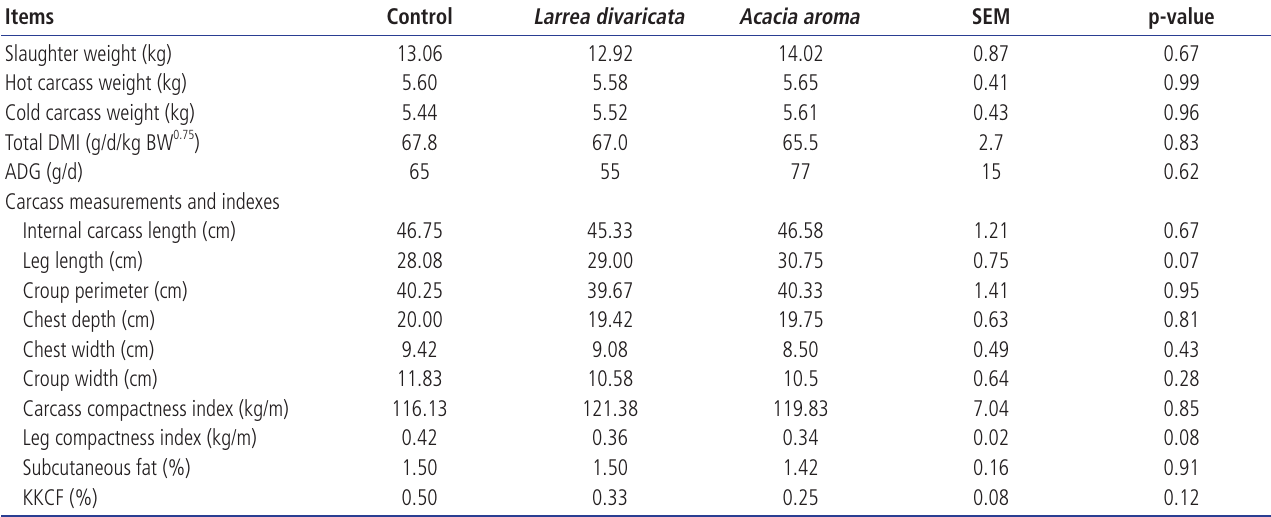
Table 2. Effects of tannin-rich leaves in diets on growth performance and carcass traits of goats Items Control Larrea divaricata